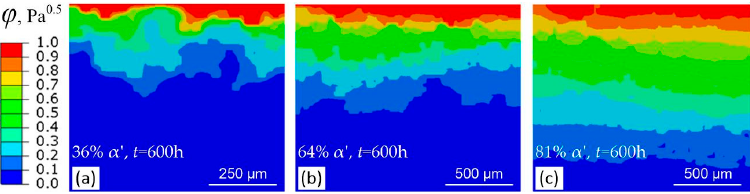
Figure 17. Normalized concentration distributions after 600 h diffusion at different α′ volume fractions: ( a ) 36% vol. α′ ; ( b ) 64% vol. α′ ; ( c ) 81% vol. α′ .